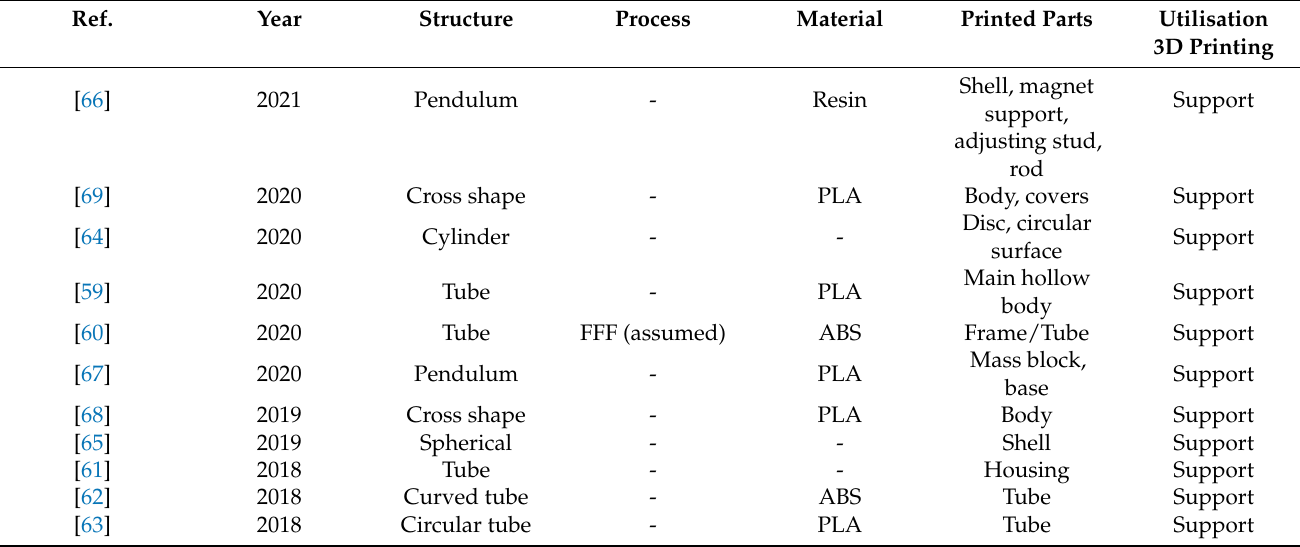
Table 5. Comparison of applied 3D printing techniques for hybrid electromagnetic vibration harvesters.